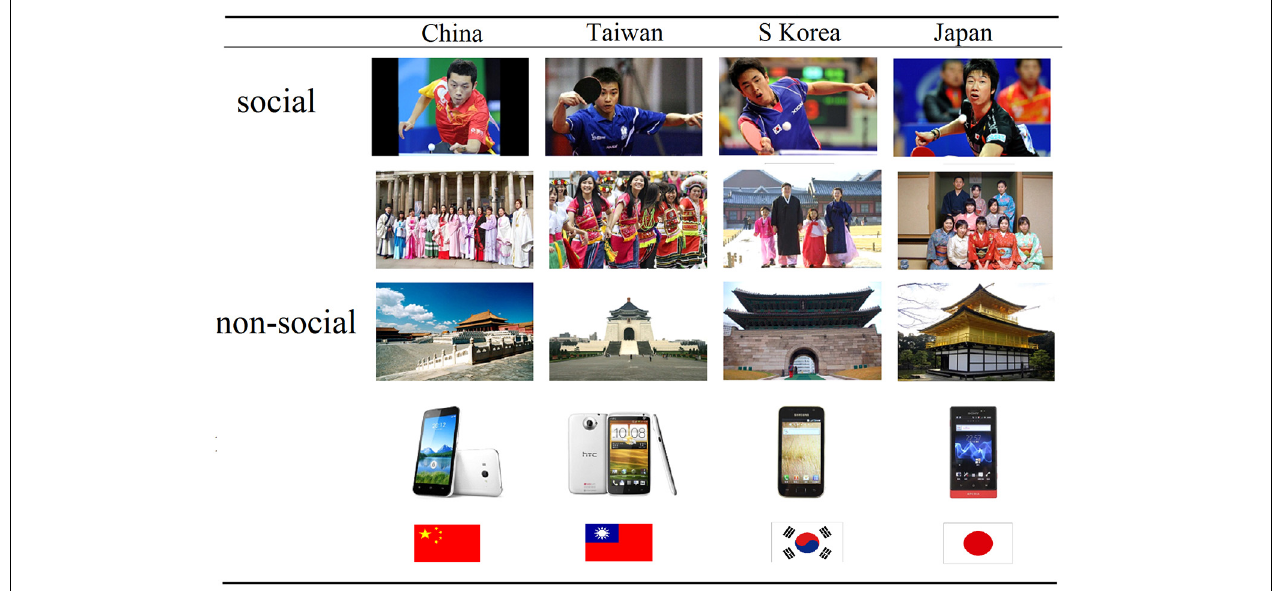
FIGURE 1 | Examples of stimuli: social and non-social Chinese, Taiwanese, Japanese, and South Korean stimulus pictures used in the study. The bottom row of pictures (mobile phones) also shows the size of the country flag which appeared under each of the stimuli presented at aid identification of